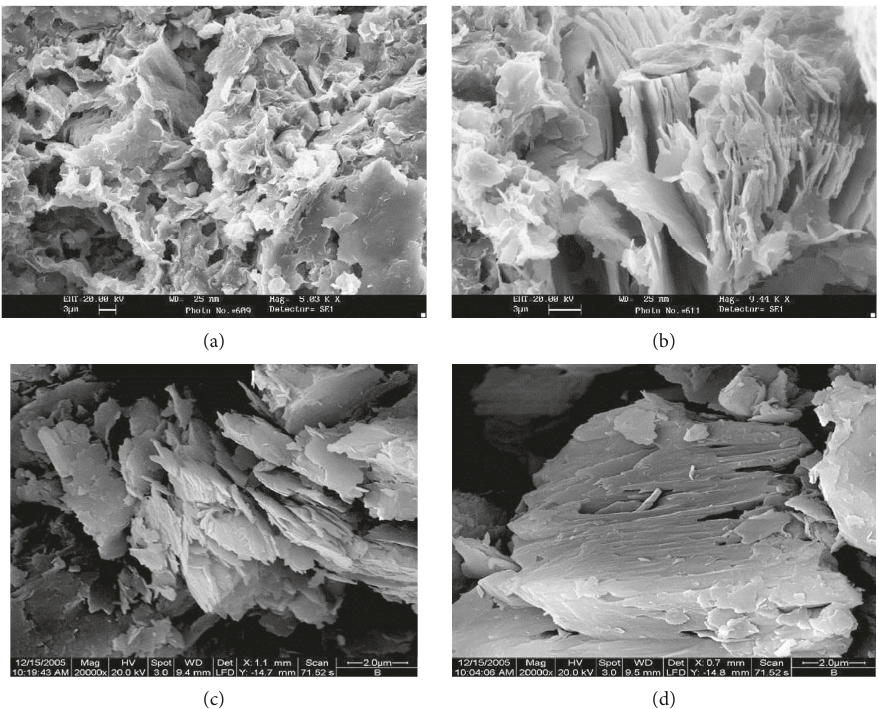
Figure 4: SEM images of red clay samples in Zhujiang new city station. (a) × 5030 flake-flocculent I/C and quartz crystal. (b) × 9440 flake I and K and flake-flocculent I/S. (c) × 20,000 leaf shaped and laminated C. (d) × 20,000 leached K-F crystal, containing fibrous sepiolite.